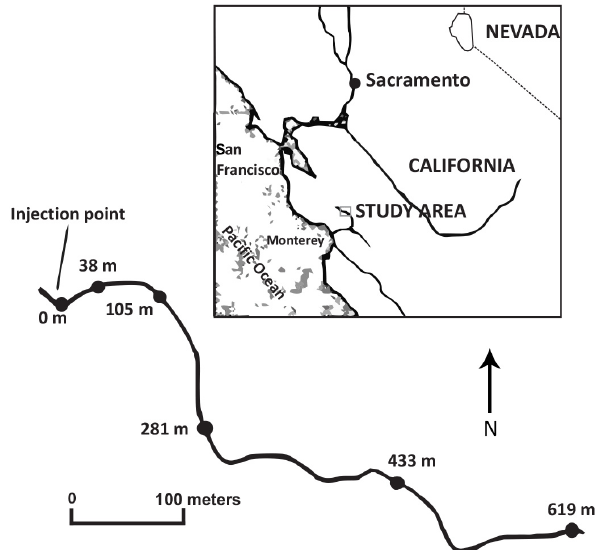
Figure 12. Uvas Creek (Santa Clara County, California) tracer study site map (Bencala and Walters,